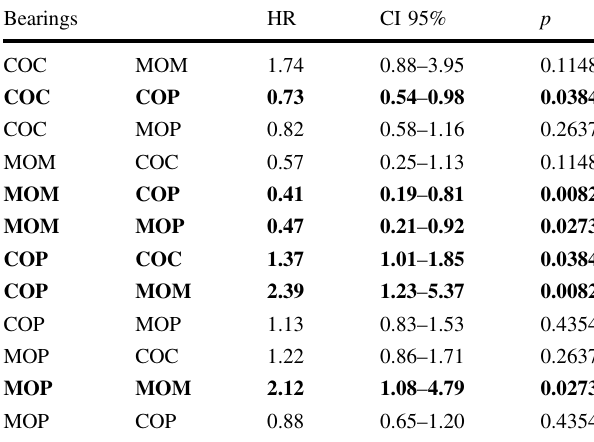
Table 3 Cox regression model investigating the in fl uence of bearings on revisions for dislocation was adjusted for age, gender, and head diameter (28 mm): in bold, signi fi cant fi ndings